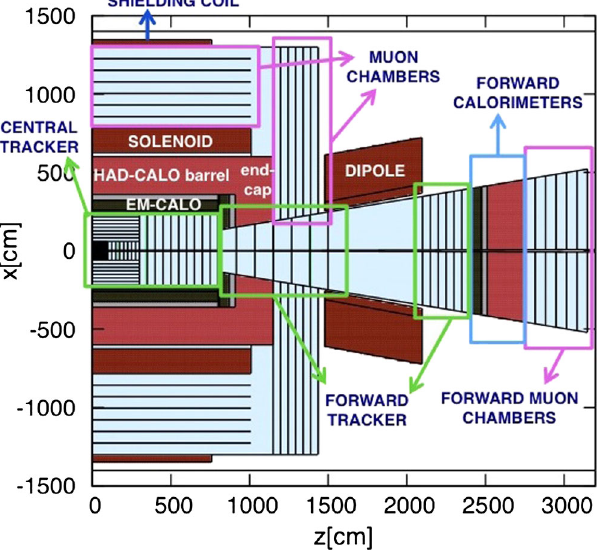
FIG. 1. Detector layout: top view. A detailed description is reported in the